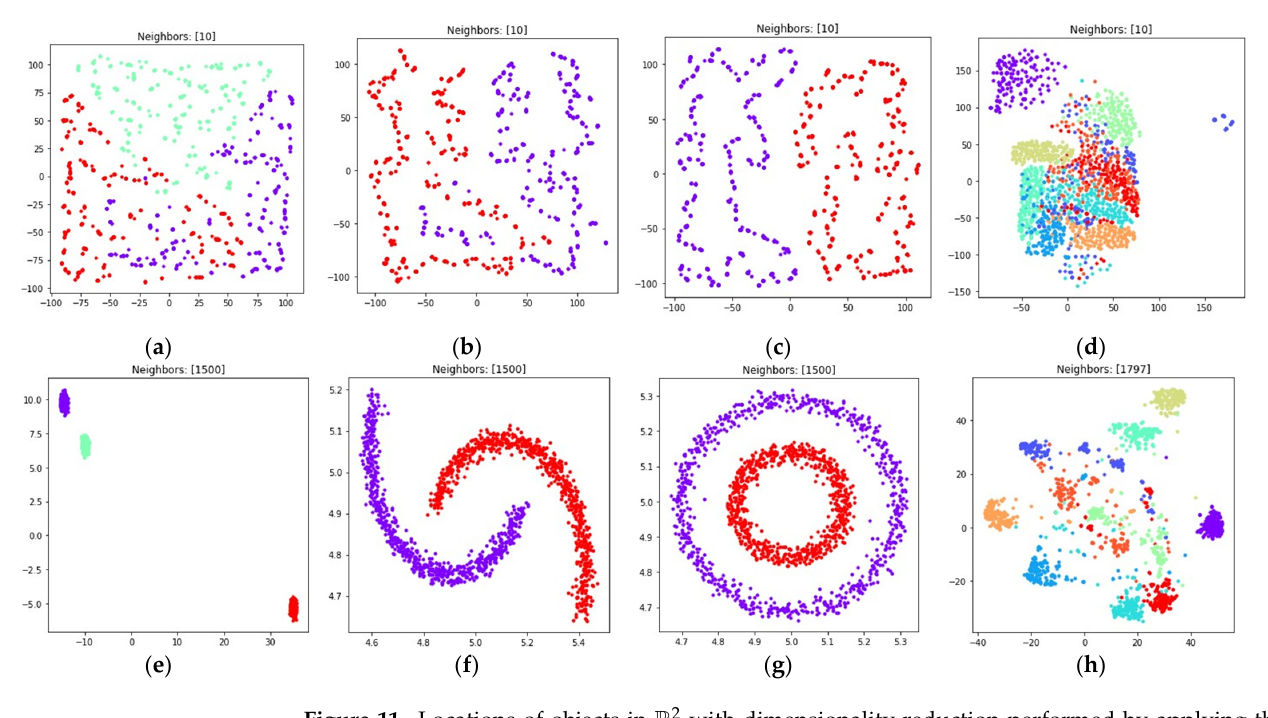
Figure 10. Locations of objects in R 2 with dimensionality reduction performed by applying the UMAP algorithm, with low dimensional embedding optimized by the Adam algorithm, symmetric fuzzy cross entropy loss, and the gradient (34) with d min set to 1 for: ( a ) blobs, k = 10; ( b ) moons, k = 10; ( c ) circles, k = 10; ( d ) handwritten digits, k = 10; ( e ) moons, k = ( n − 1 ) ; ( f ) blobs, k = ( n − 1 ) ; ( g ) circles, k = ( n − 1 ) ; ( h ) handwritten digits, k = ( n − 1 ) .